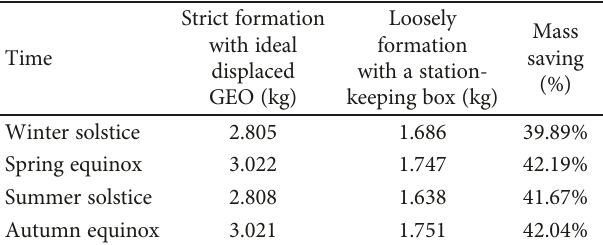
Table 4: Mass consumption for all spacecrafts after one